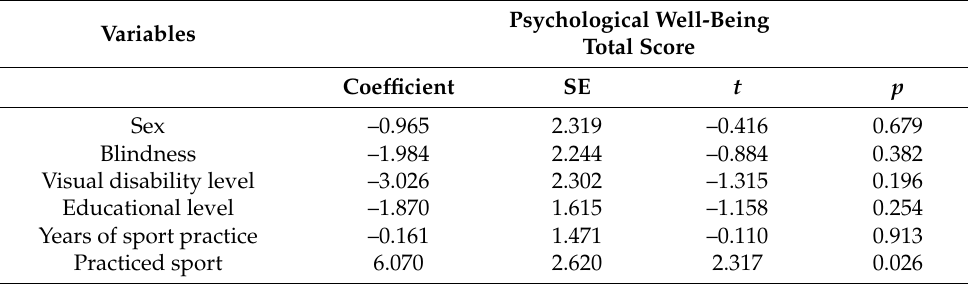
Table 3. Multiple linear regression analysis of characteristics of visually impaired athletes to predict psychological well-being.